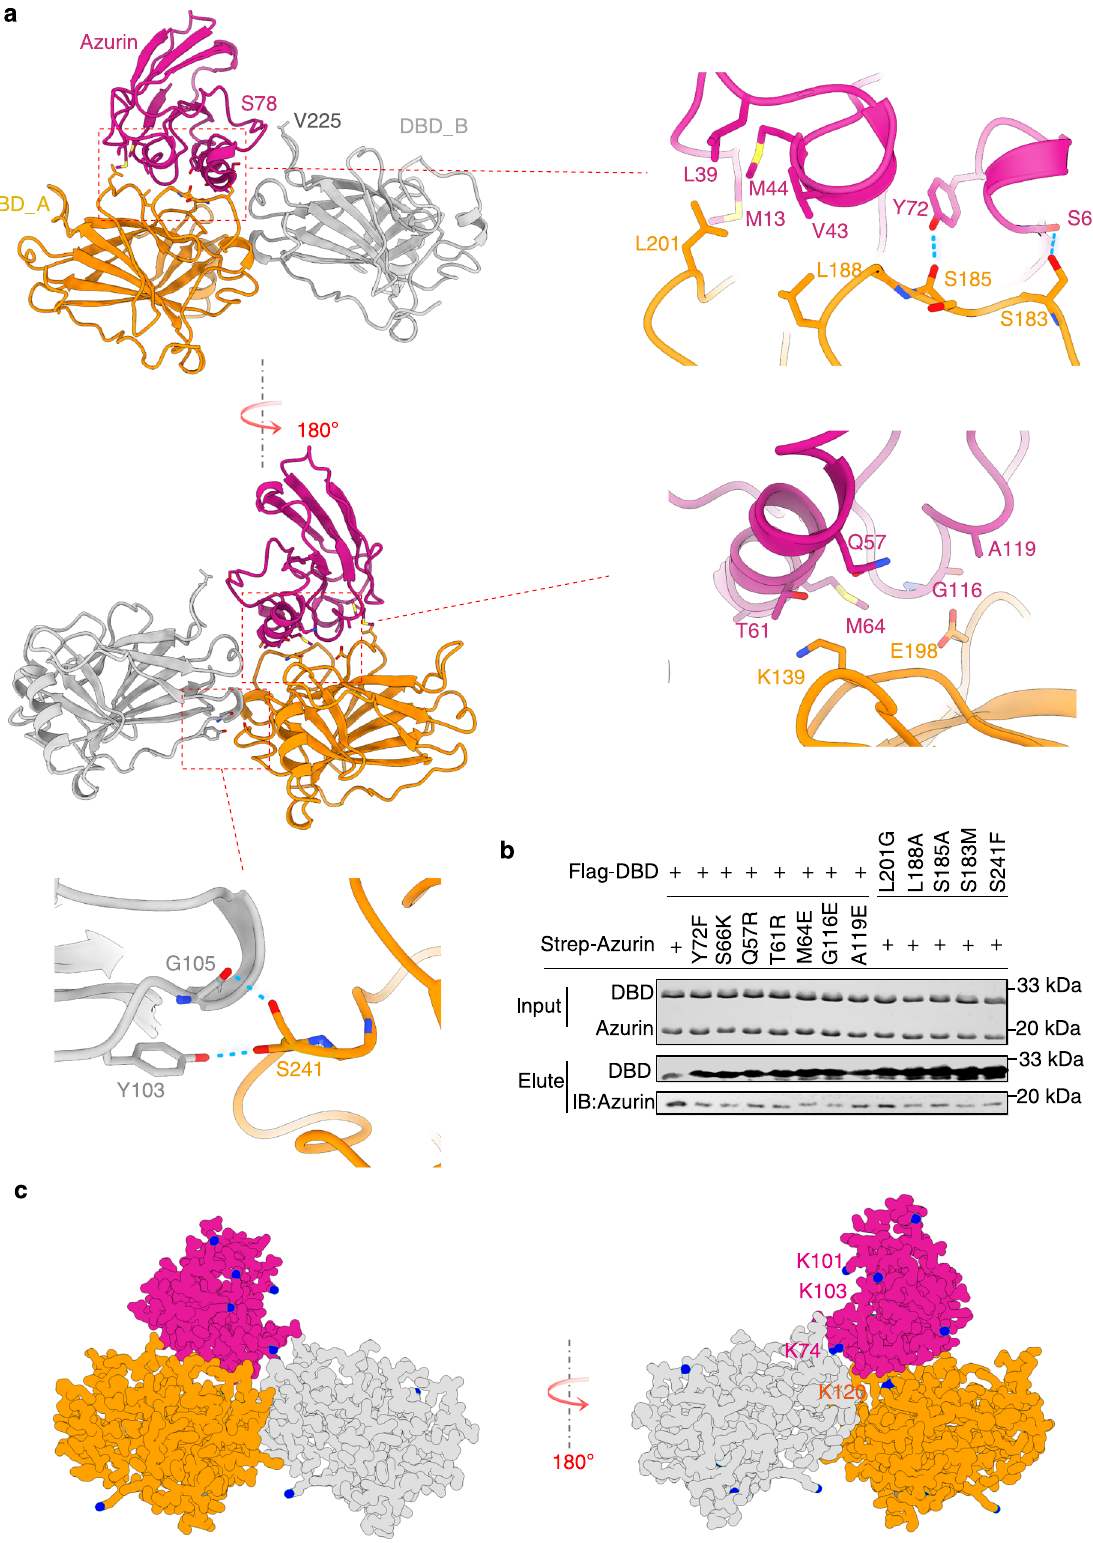
of apoptotic cells. While cells treated with azurin WT, azurin V43I, azurin Q57E, azurin S78I and azurin A119K, led to ~7.3%, 9.0%, 10.4% and 12.7% of cell death, respectively (Fig. 5a, b). Additionally, the level of p53 was marginally elevated with WT azurin treatment as compared to phosphate buffer treatment (Fig. 5c). However, when cells treated with azurin mutants